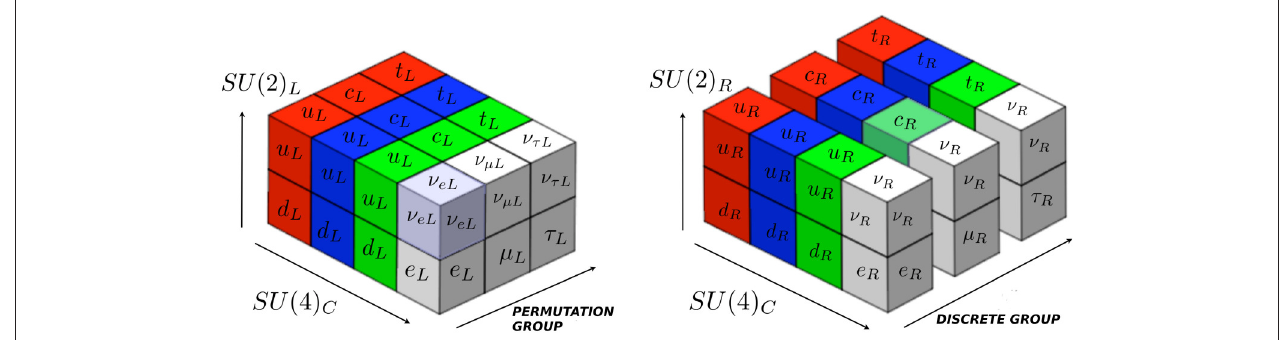
FIGURE 10 | Pictorial representation of a possible particle assignment in models with [ PS